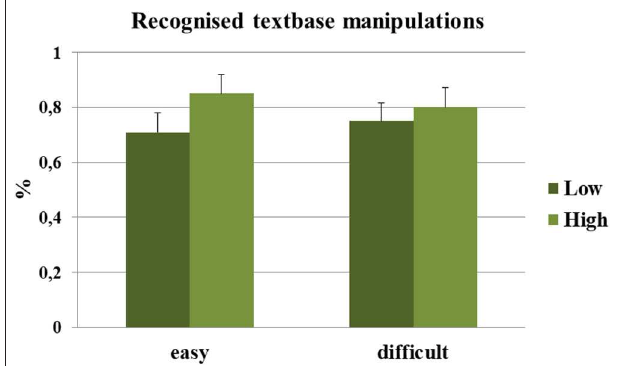
FIGURE 5 | Mean percentages of correctly recognized textbase manipulations’ between text difficulty conditions for low and high WMC